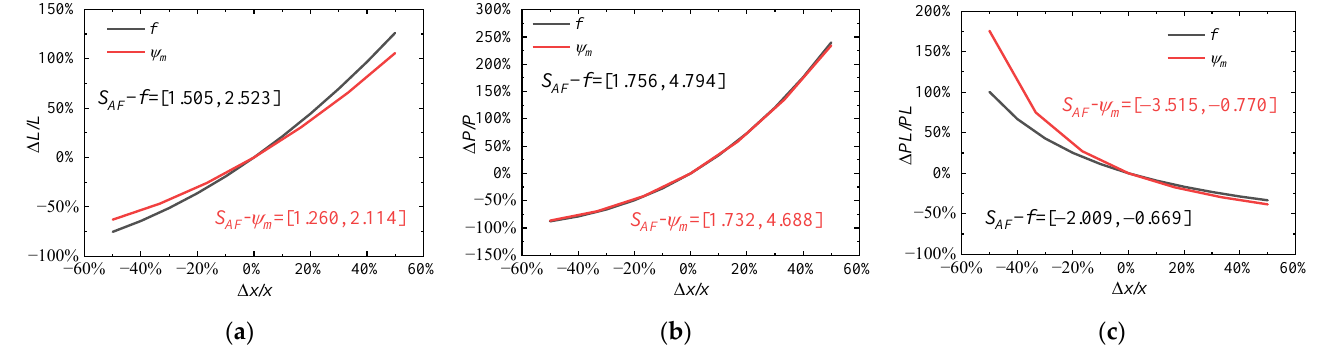
Figure 17. Comparison of sensitivity analysis results for the flapping frequency and sweeping amplitude. ( a ) Sensitivity of lift. ( b ) Sensitivity of aerodynamic power. ( c ) Sensitivity of power loading.